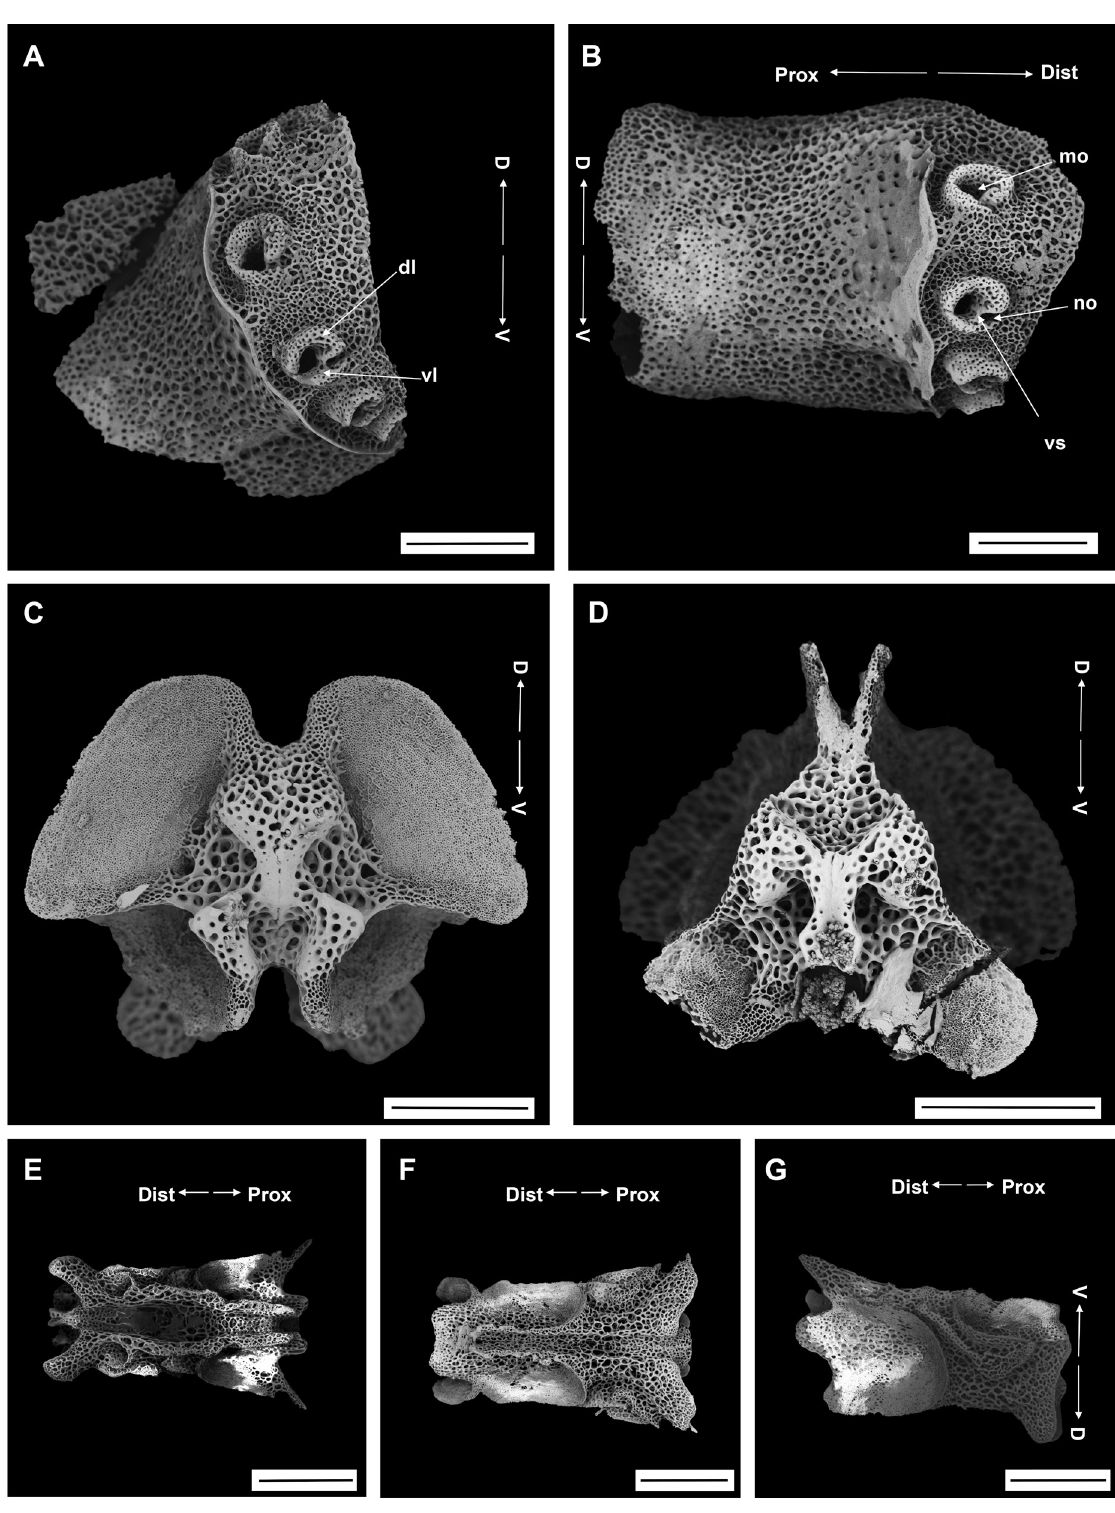
Fig. 16. Ophiotreta eximia (Koehler, 1904), SEM (IDSSE EEB-SW0030). A–B . Lateral arm plate. C–G . Vertebrae. C . Proximal view. D . Distal view. E . Ventral view. F . Dorsal view. G . Lateral view. Abbreviations: D = dorsal; Dist = distal; dl = dorsal lobe; mo = muscle opening; no = nerve opening; Prox = proximal; V = ventral; vl = ventral lobe; vs = volute-shaped. Scale bars: A–D = 300 µm; E–G = 500